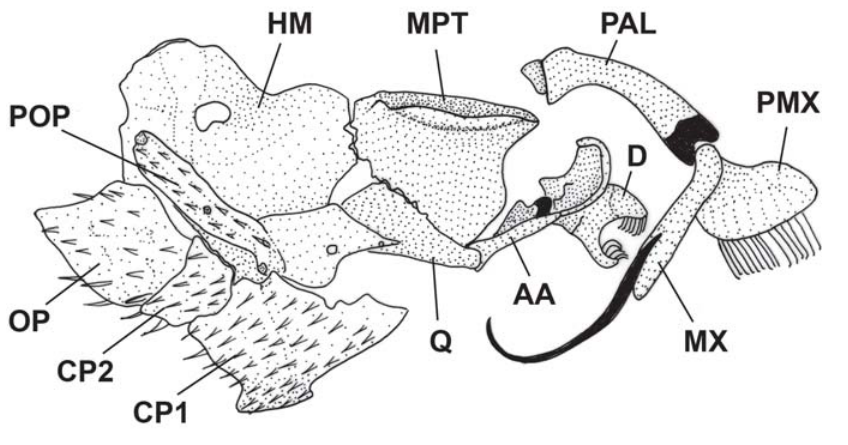
Fig. 9. Suspensorium of Otothyropsis marapoama . Paratype, LIRP 5641, 29.0 mm SL.